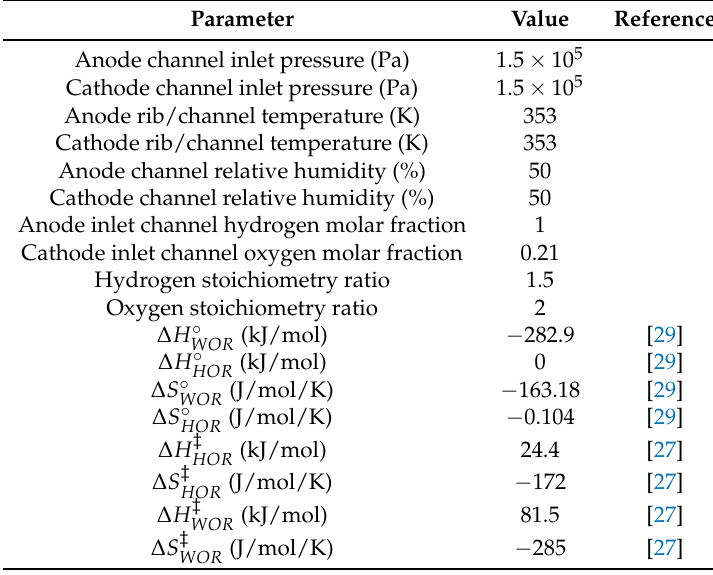
Table 1. Parameters for the